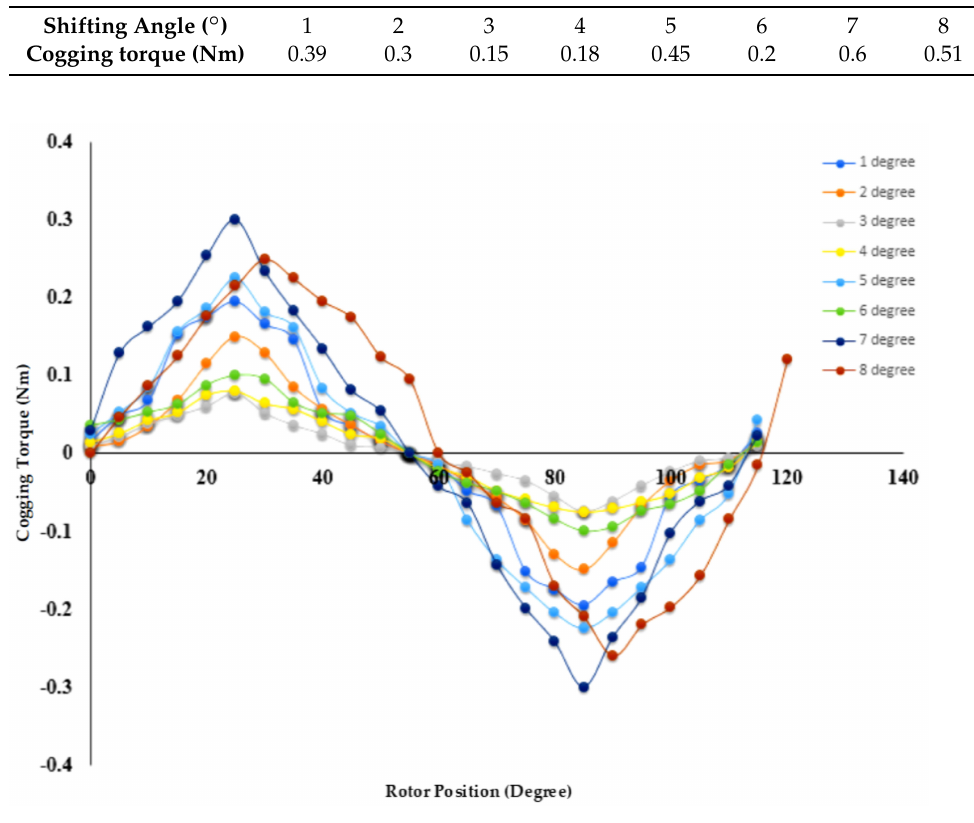
Figure 4. Analytical results of cogging torque with shifting angles from 1 ◦ to 8 ◦